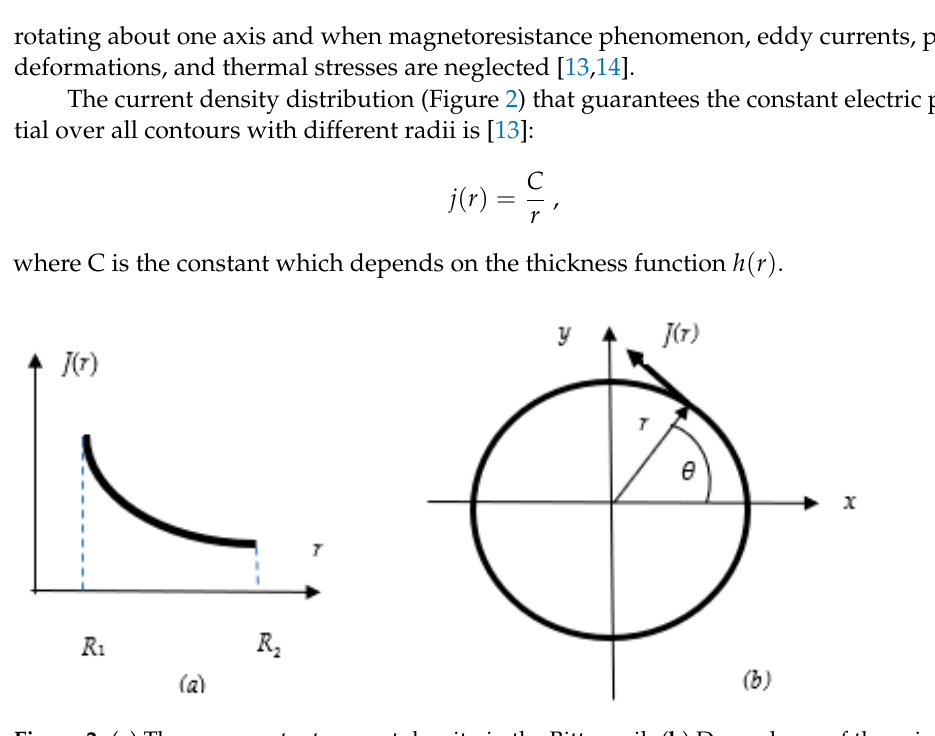
Figure 2. ( a ) The non-constant current density in the Bitter coil. ( b ) Dependence of the azimuthal current density of the angle θ .